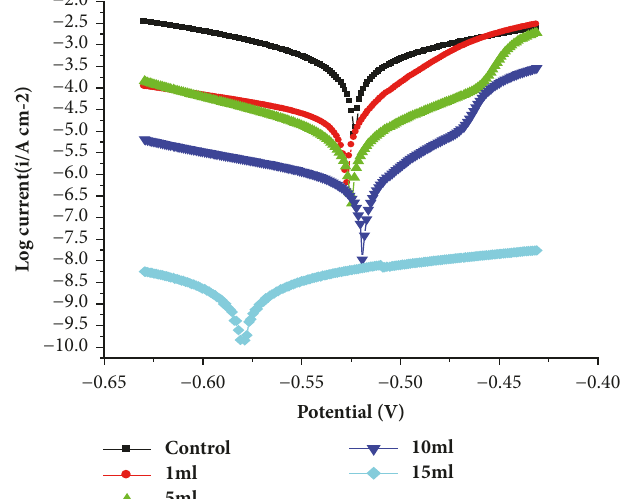
Figure 6: Variation of potential (E) against log current (A) for different volumes of oil extracts and cathodic protection of steel with zinc in 0.1M sulphuric acid.